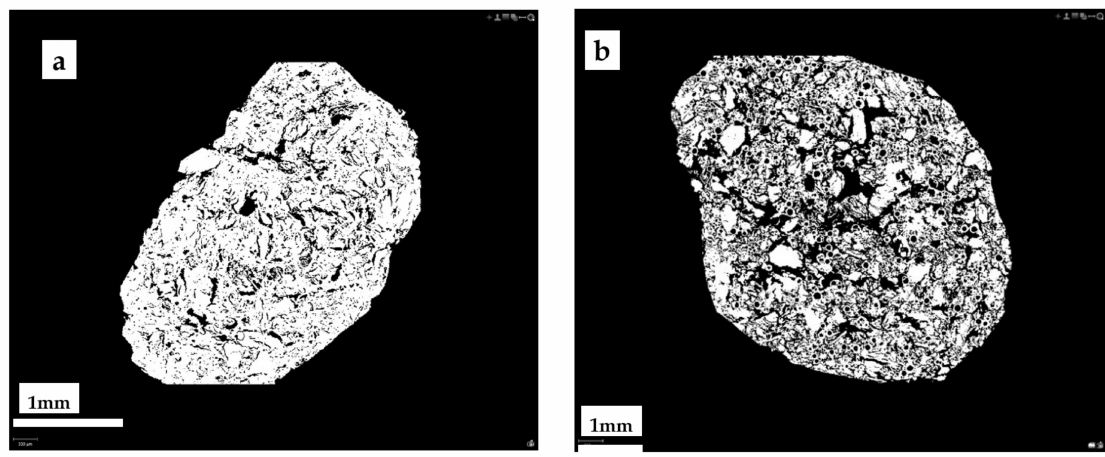
Figure 7. Photomicrographs of MCt cross-sections of granules 0-100-0 ( a ) and 5-90-5 ( b ).